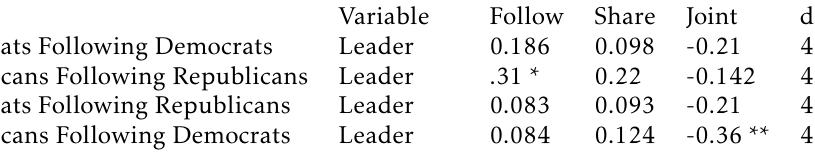
Table 8. Correlation between Network Centrality and DW-Nominate for party subsets